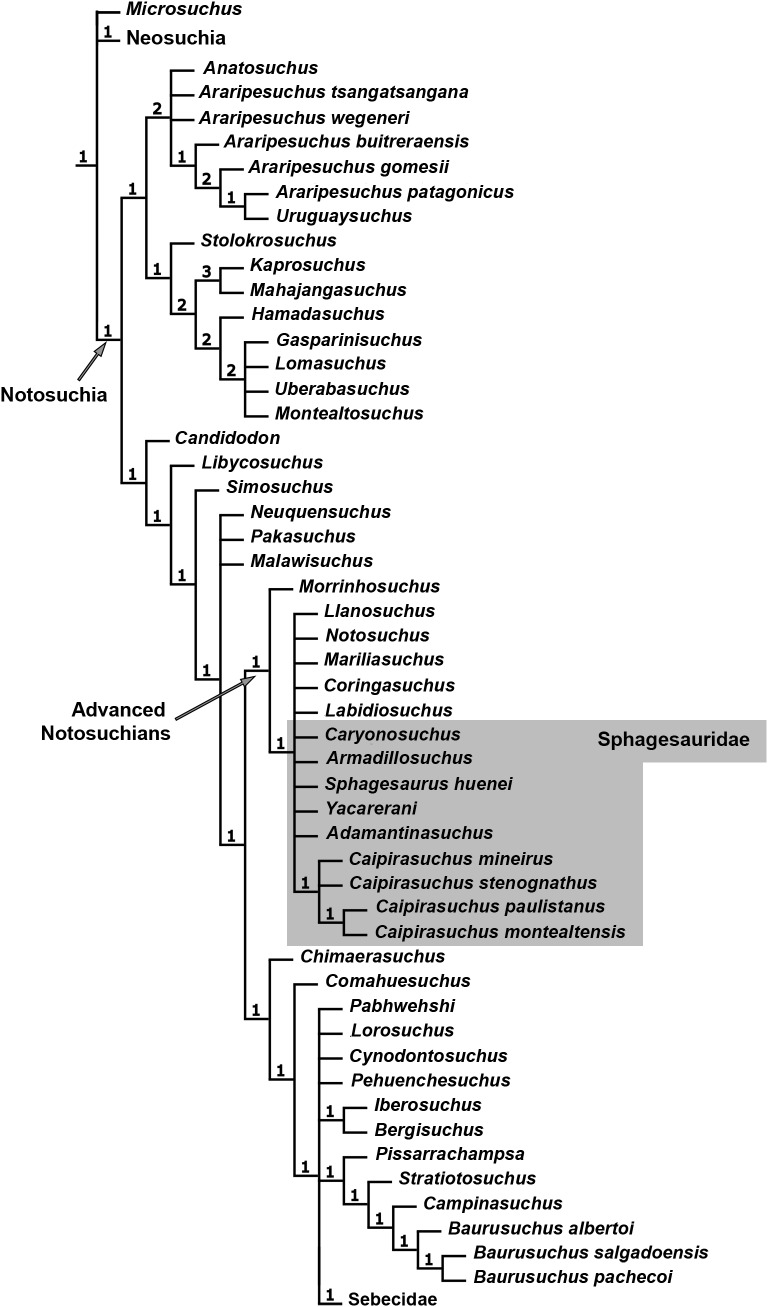
Phylogenetic position of C. mineirus.Reduced strict consensus tree depicting the phylogenetic relationships of notosuchians.